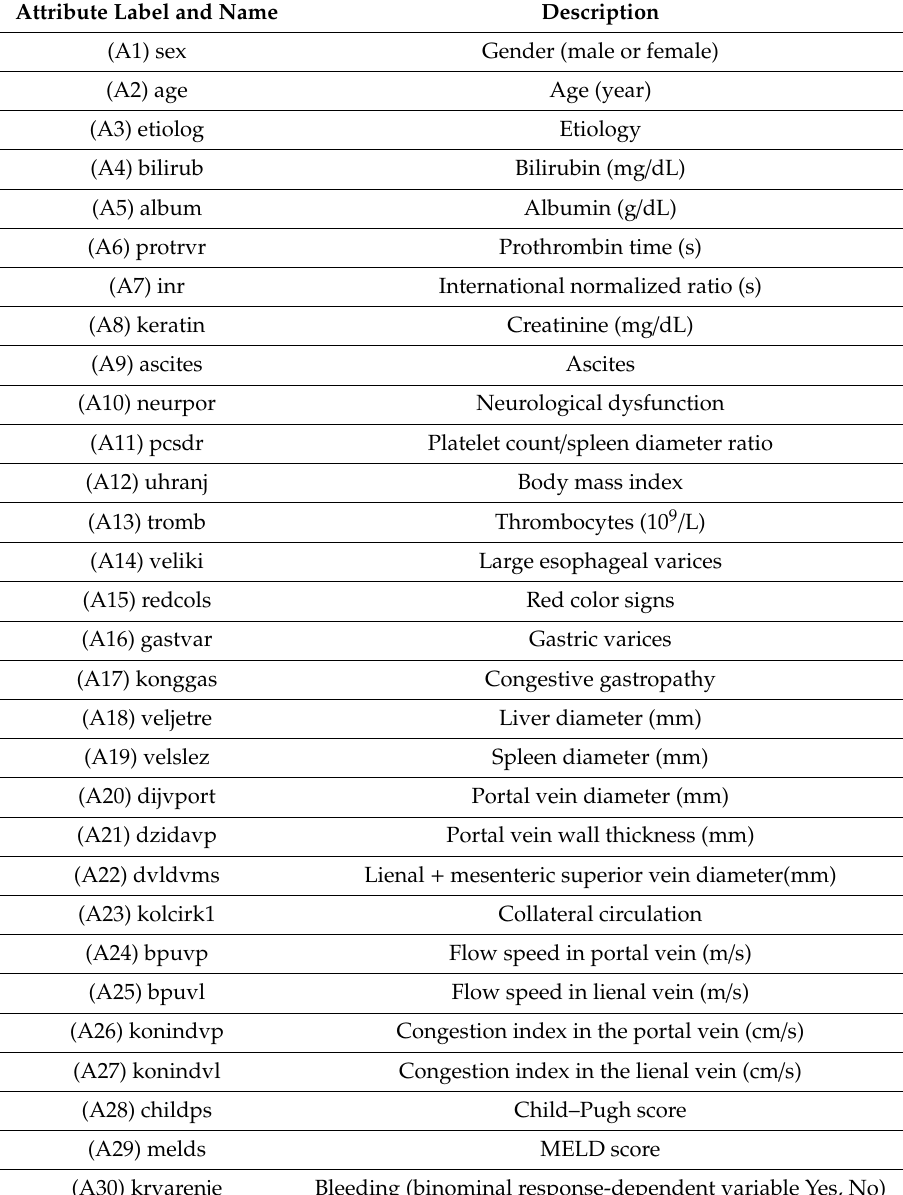
Table 2. List of features used in